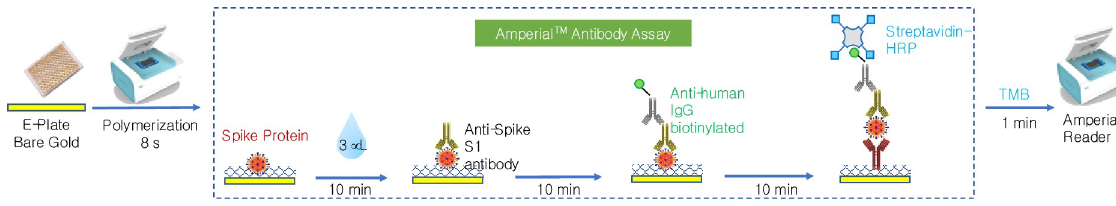
Fig 1. Schematic of the Amperial ™ saliva anti-SARS-CoV-2 IgG assay. See methods for description.